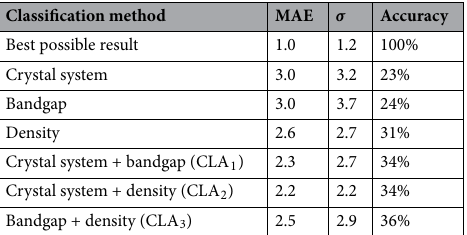
Table 4. Comparison of the hardness MAE (GPa) and standard deviation σ (GPa) for various classification methods. Accuracy was calculated with respect to the best possible result.